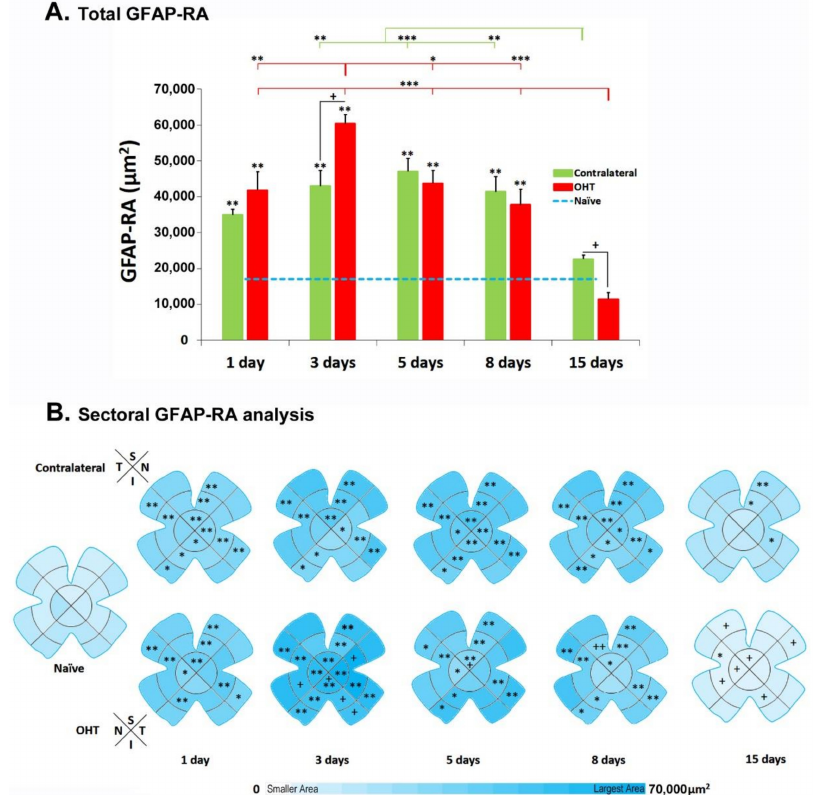
Figure 9. GFAP-RA values at different time points after unilateral OHT laser induction. ( A ): Histogram shows the mean values of total GFAP-RA ( ± SD) at different time points after laser treatment (1, 3, 5, 8 and 15 days) in contralateral and OHT eyes. Dashed line represents GFAP-RA measurements in naïve eyes. The GFAP-RA total increase at 1 day remained statistically elevated until 8 days, being more intense at 3 and 5 days after laser in both OHT eyes and contralateral eyes. ** p < 0.01 OHT vs. naïve and contralateral vs. naïve; Mann–Whitney U test. + p < 0.05 OHT vs. contralateral; Wilcoxon W test. ( B ): Colorimetric differences in the GFAP-RA by retinal sector in naïve eyes and at different time points after laser treatment (1, 3, 5, 8 and 15 days) in contralateral and OHT eyes. * p < 0.05, ** p < 0.01 OHT vs. naïve and contralateral vs. naïve; Mann–Whitney U test. + p < 0.05, ++ p < 0.01 OHT vs. con- tralateral; Wilcoxon W test. GFAP: glial fibrillary acidic protein; GFAP-RA: GFAP-labeled retinal area; OHT: ocular hypertension; S: superior; I: inferior; N: nasal; T: